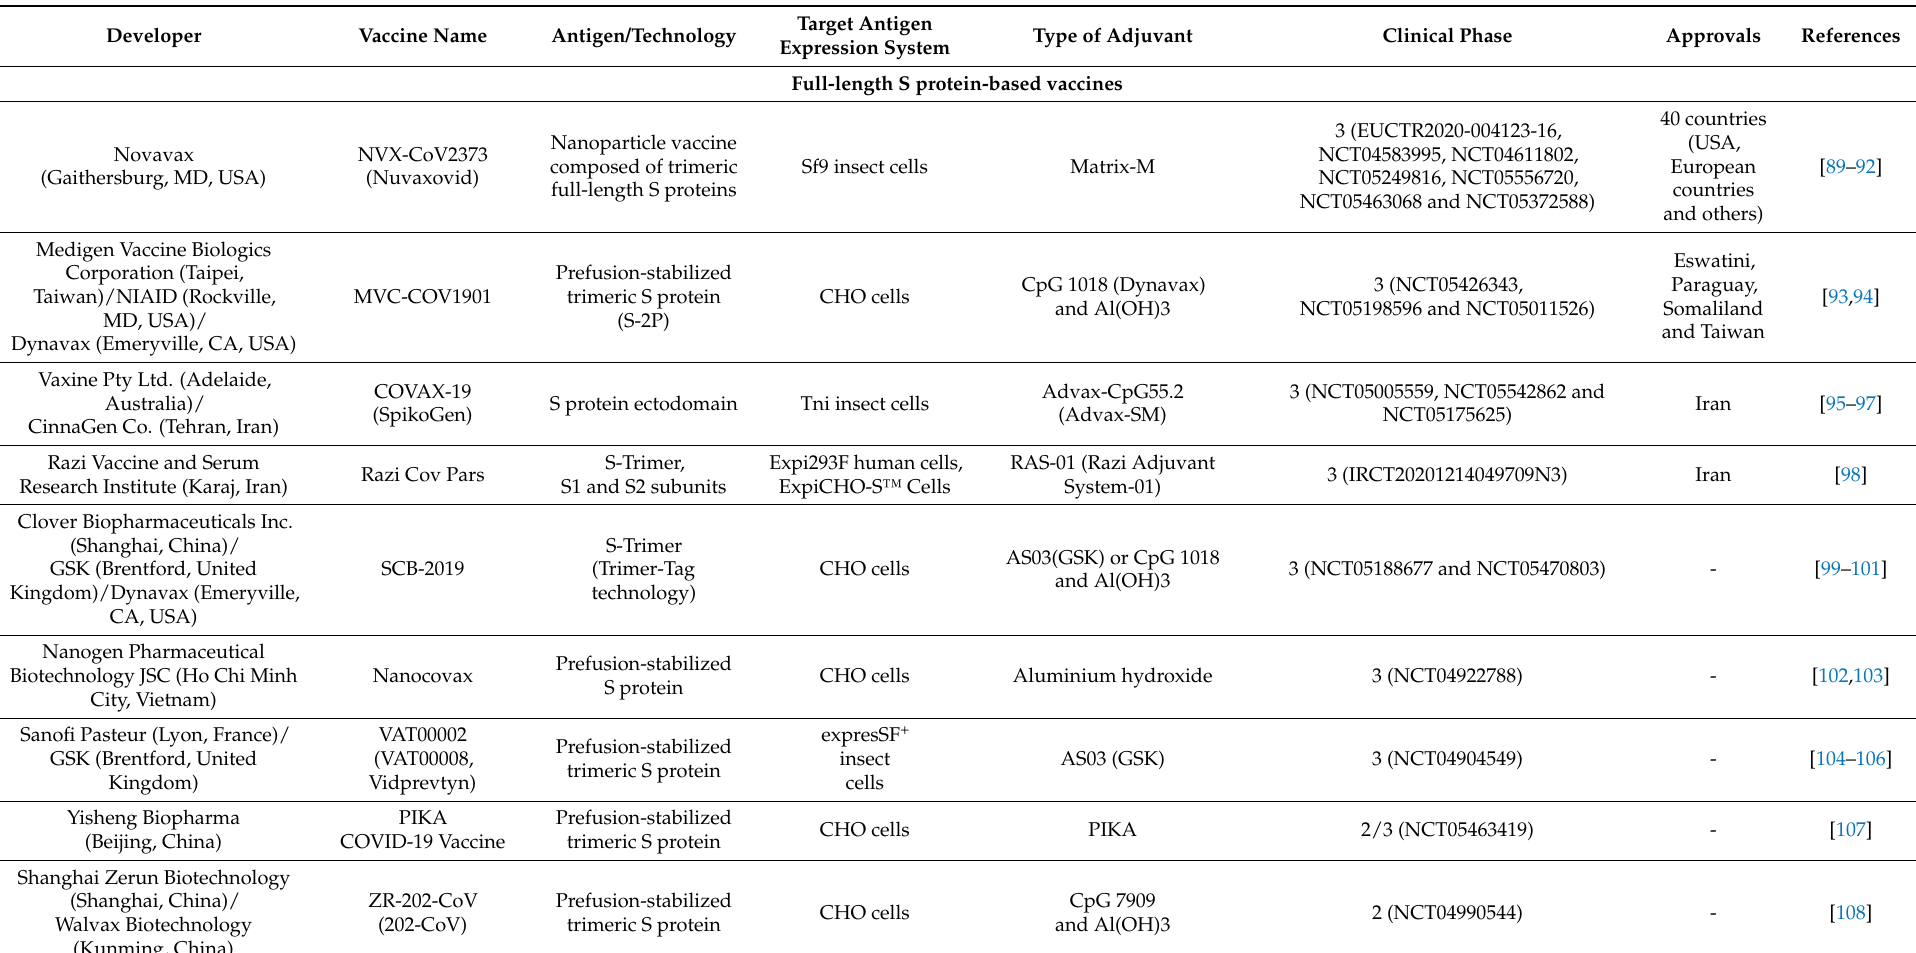
Table 2. Several recombinant protein vaccines against COVID-19 in clinical trials and pre-clinical studies as of 25 October